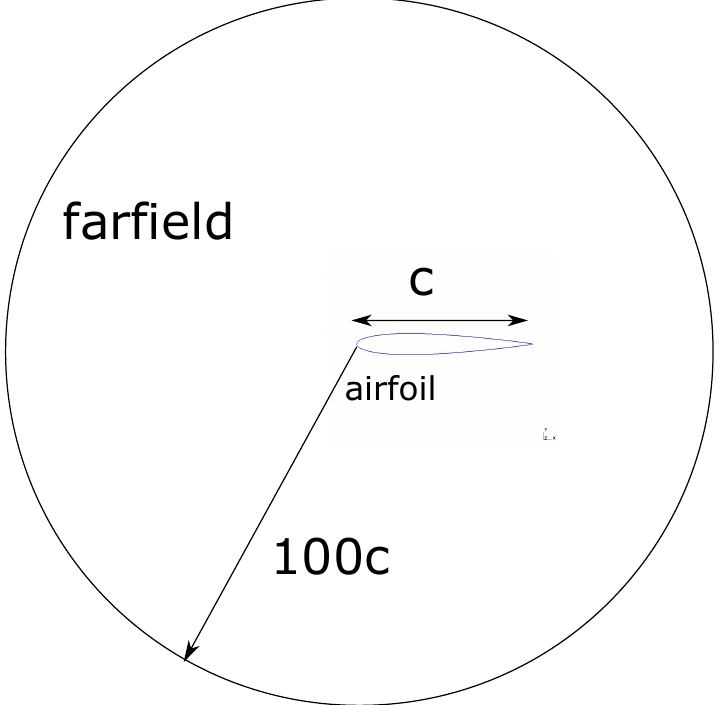
Figure 2. Computational domain around airfoil, but the airfoil is out of scale. The farfield boundary is a circle of the radius of 100 c centered around the airfoil leading